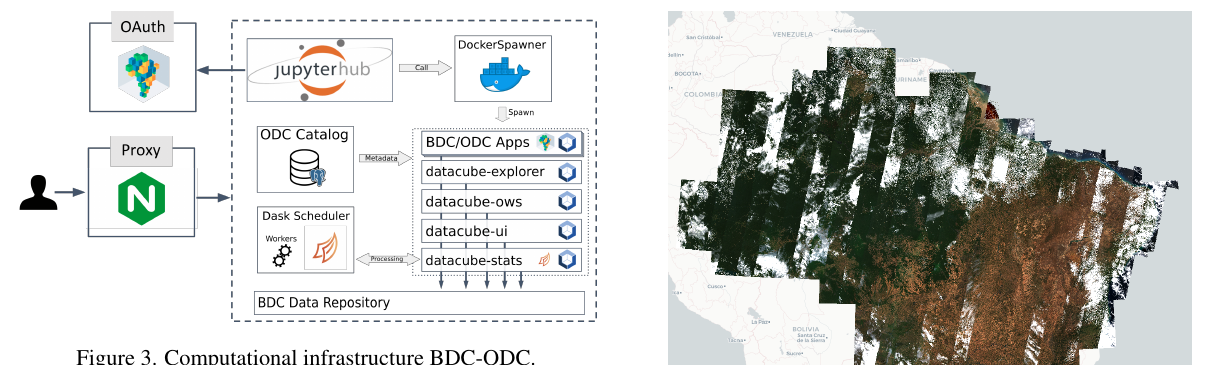
Figure 3. Computational infrastructure BDC-ODC.